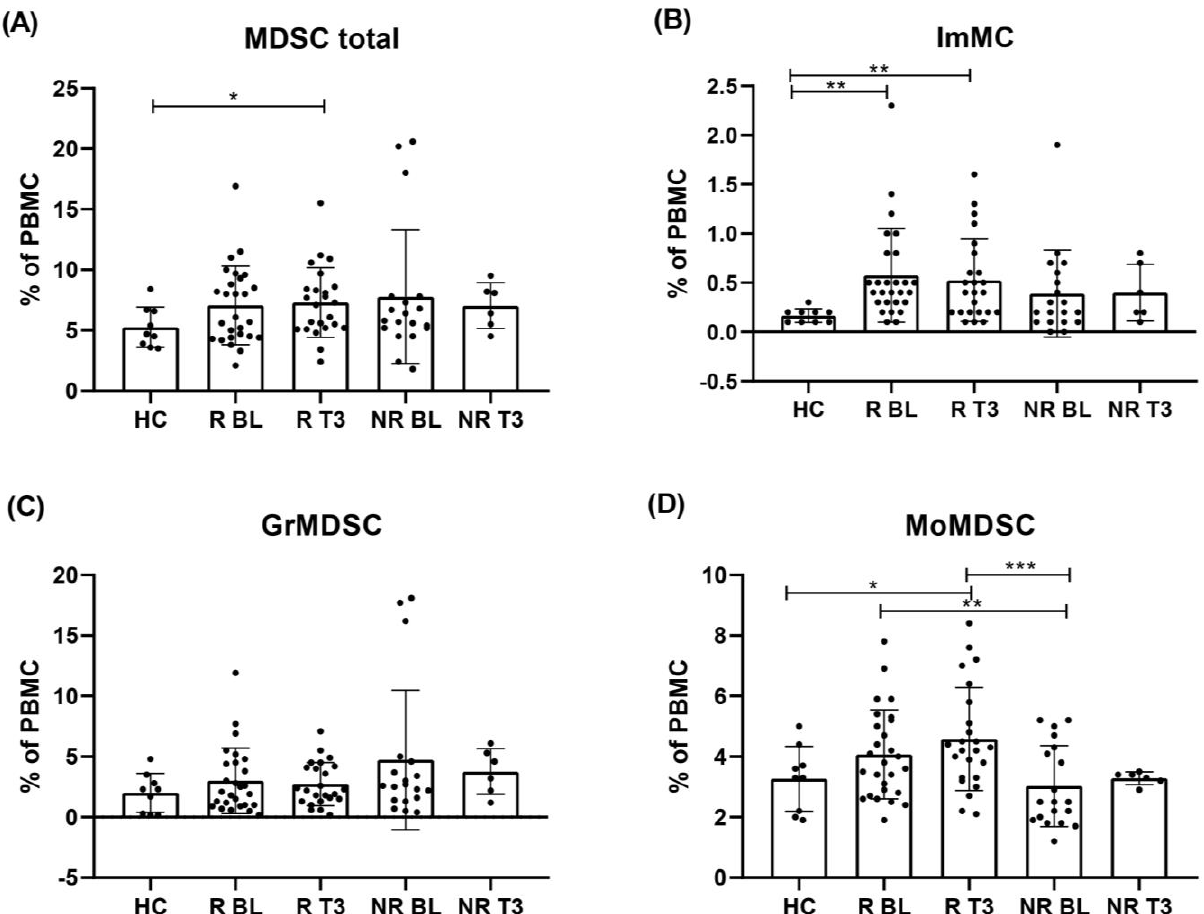
Figure 4. Levels of circulating MDSC total cells, ImMC, GrMDSC and MoMDSC following immunotherapy. Patients’ MDSC levels were evaluated as % of PBMC and presented in the context of clinical benefit in two time points: baseline (BL) and third month of anti-PD-1 therapy (T3). Occurring response to therapy was measured in the third month of treatment. Responders group (R) included patients with PR and SD, non-responders (NR)- PD. ( A ) Levels of total MDSC grouped by patients’ response to anti-PD-1 therapy. Levels of ( B ) immature monocytic cells (ImMC), ( C ) granulocytic MDSC (GrMDSC) and ( D ) monocytic MDSC (MoMDSC). Data are shown as a mean ± SD, * p ≤ 0.05, ** p < 0.02, *** p < 0.005. PR, partial response; SD, stable disease; PD, progressive disease.